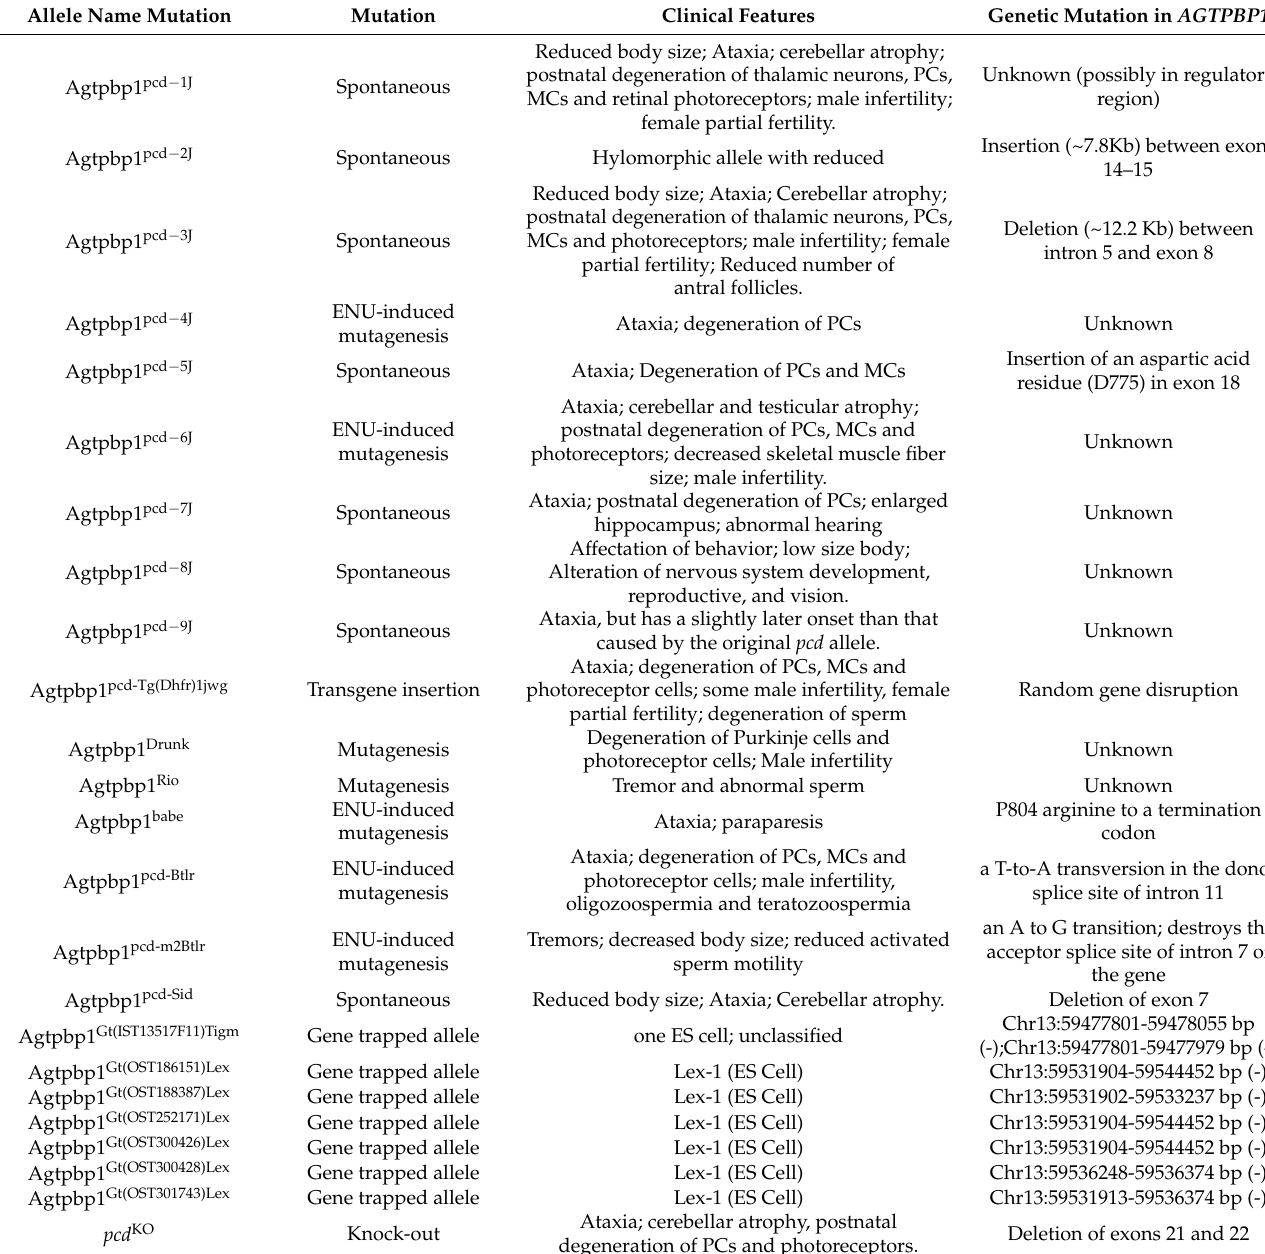
Table 3. Summary of AGTPBP1 reported mutant alleles. ENU: